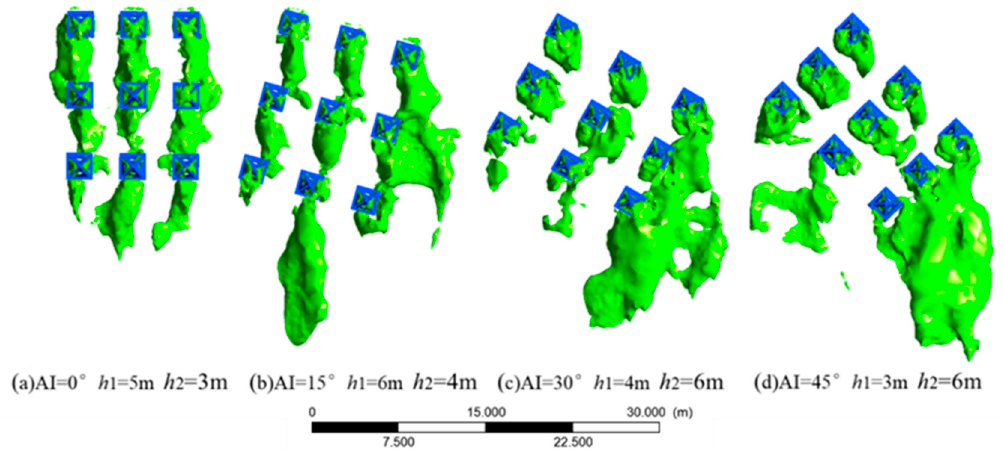
◦ , 15 ◦ , 30 ◦ , and 45 ◦ (m 3 ).